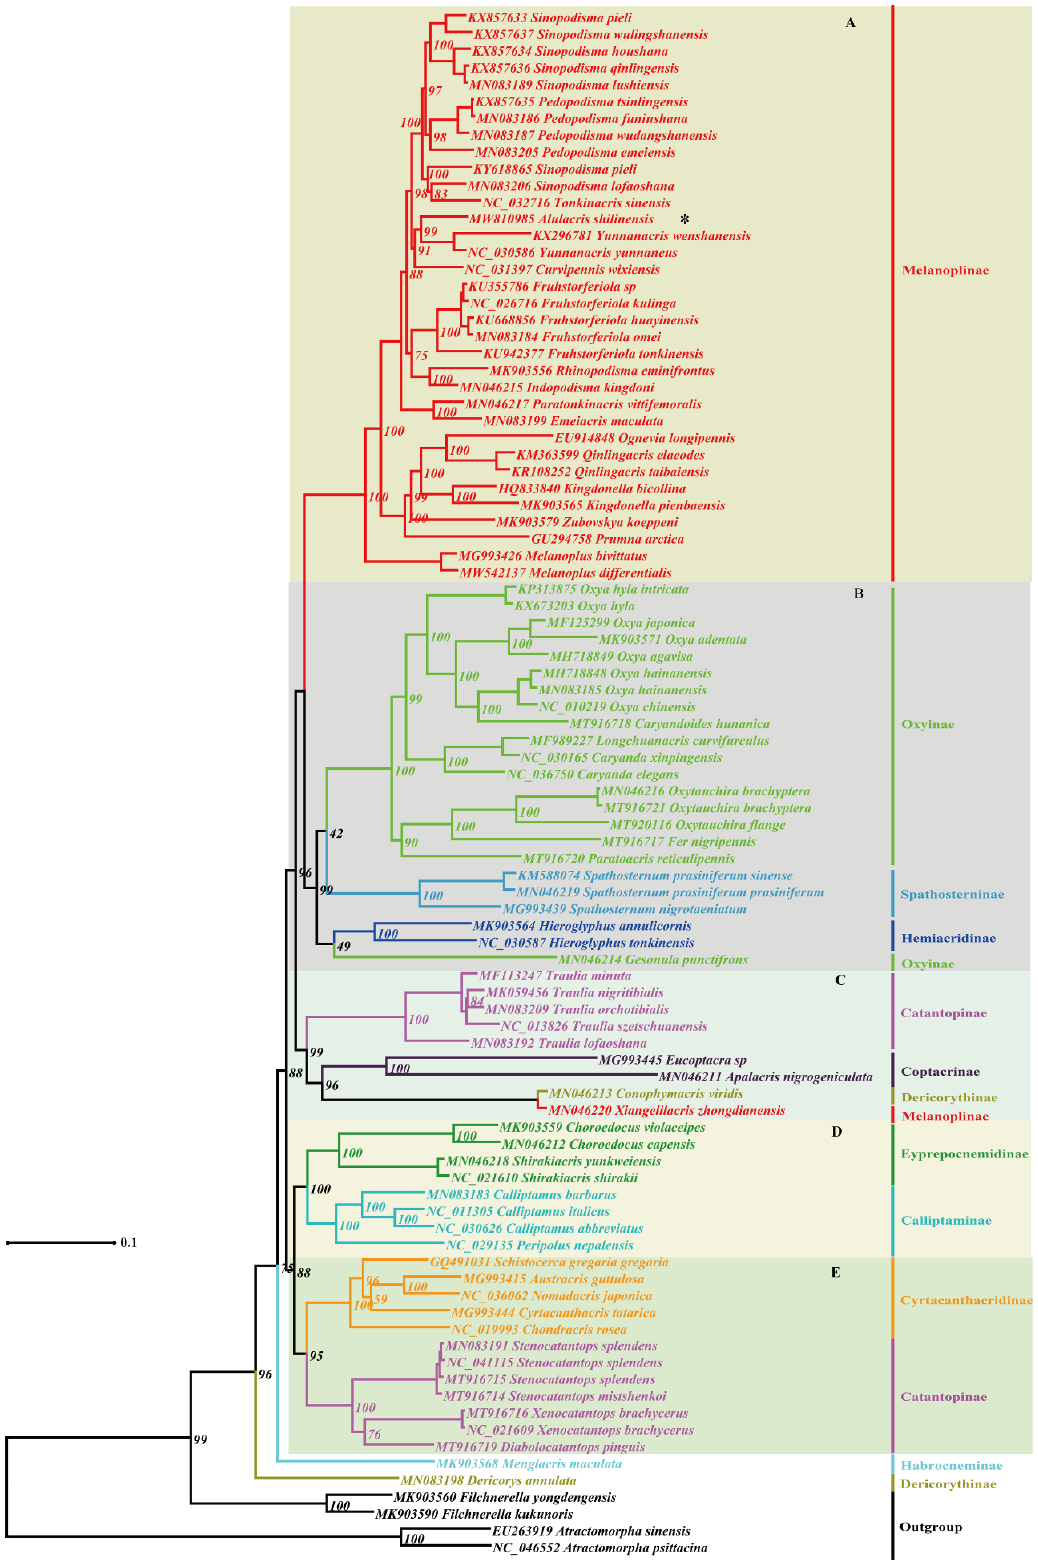
Figure 2. Phylogenetic tree reconstructed from sequences of the 13 mitogenome PCGs (protein-coding genes) and two rRNAs using maximum likelihood. The asterisk indicates the species Alulacris shilinensis . ( A ). Melanoplinae (excluding the genus Xiangelilacris ). ( B ). Oxyinae+Spathosterninae+Hemiacridinae. ( C ). Coptacrinae+ Traulia + Conophymacris + Xiangelilacris . ( D ). Eyprepocnemidinae+Calliptaminae. ( E ). Cyrtacanthacridinae+Catantopinae.